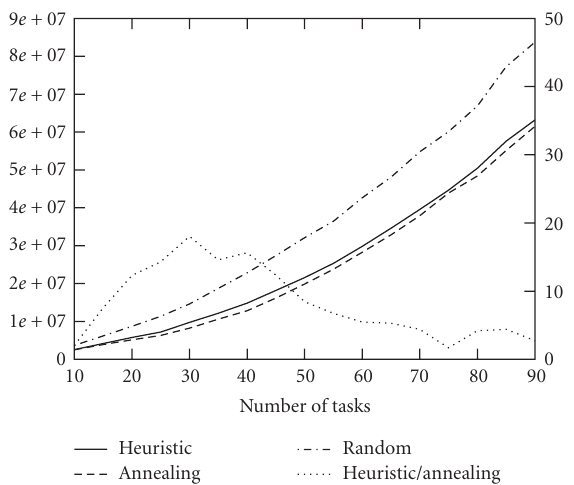
Figure 15: Objective function values for a fixed task count (60) and di ff erent array sizes.